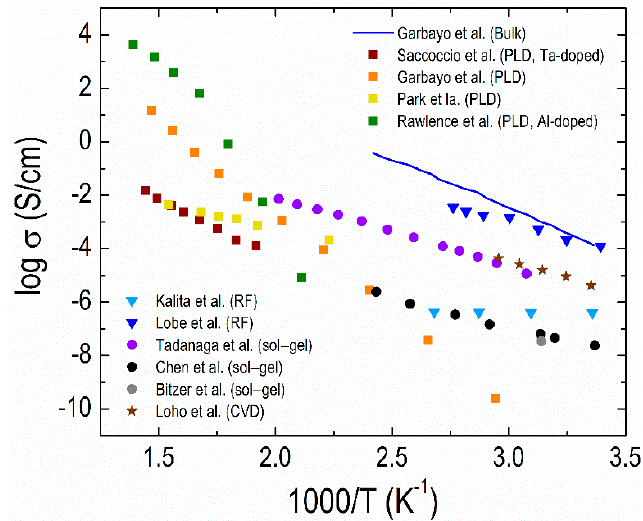
Figure 15. Conductivity summary of bulk [324] and thin-film LLZO deposited by PLD [324,430,431,437] , RF sputtering [59,432] , sol–gel [433–435] and CVD [57] .